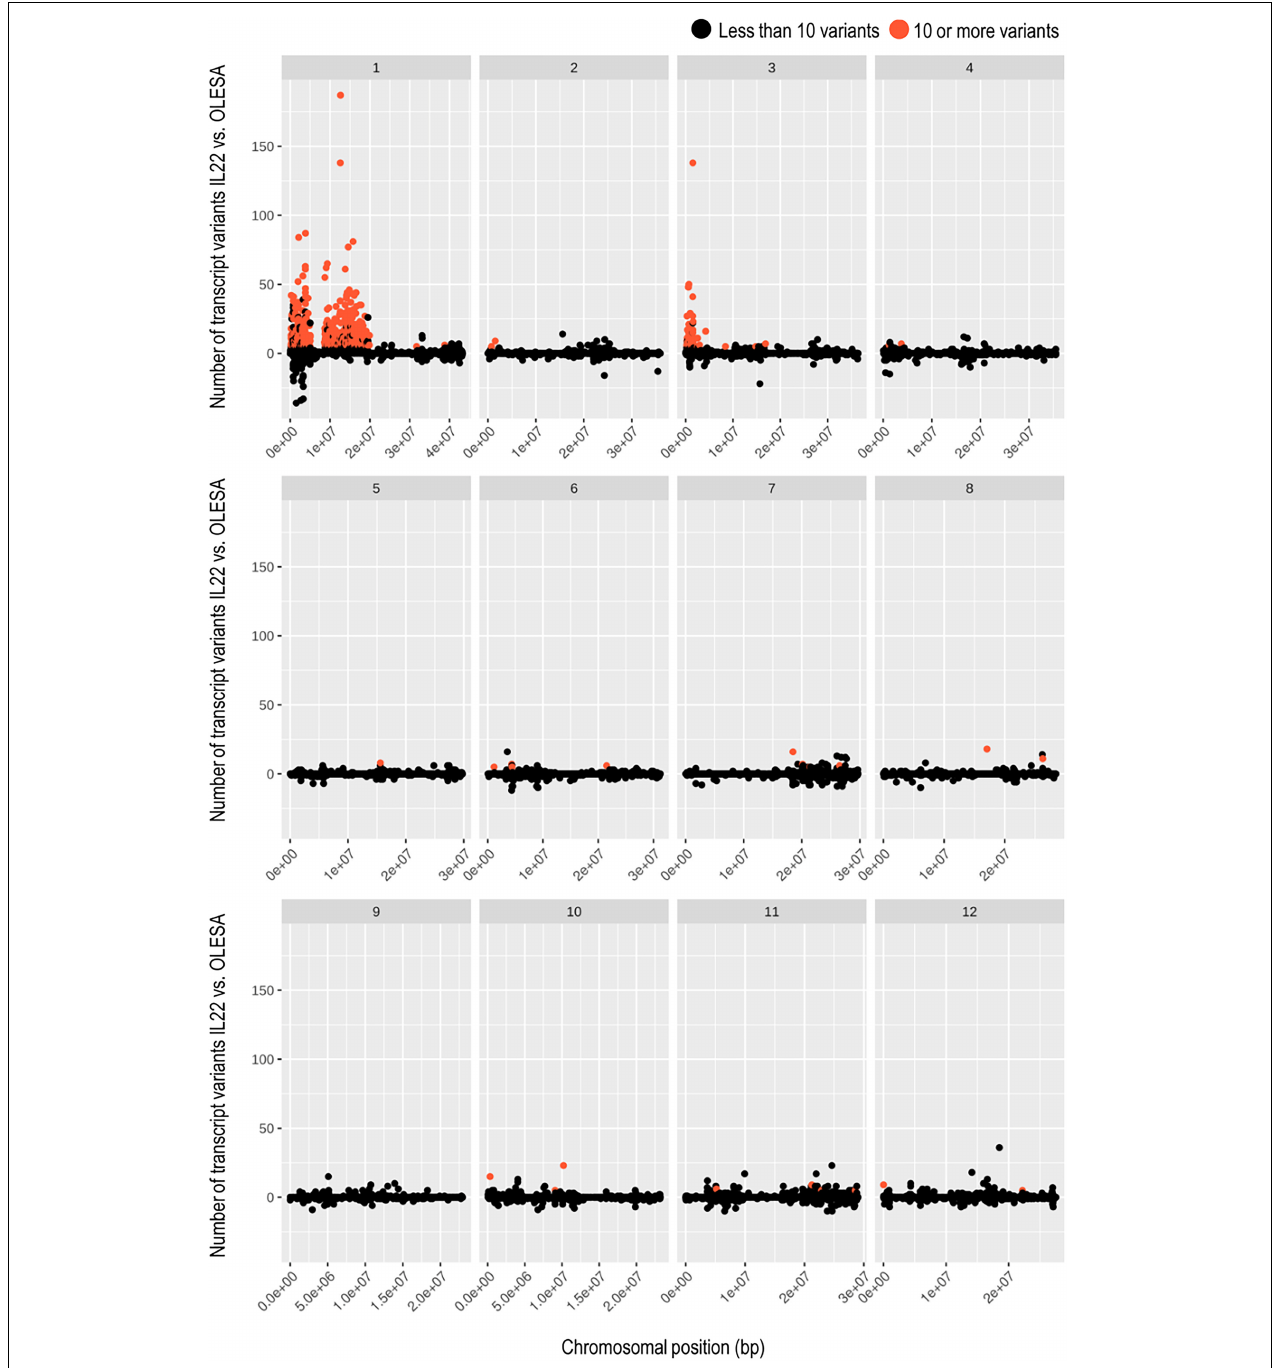
FIGURE 3 | Transcriptome-based genotyping of the introgression line IL22. Scatter plots showing the number of transcript variants for each IL22 transcript with respect to the natural variation of OLESA transcripts (both compared to japonica reference genome). Transcripts identified as indica (red dots) are those showing 10 or more variants in IL22 than in OLESA. Transcripts showing less than 10 transcript variants in IL22 compared to OLESA were considered japonica . Each chromosome (1–12) show their scatter plot and transcripts are sorted by chromosomal position, indicated in the x -axis.